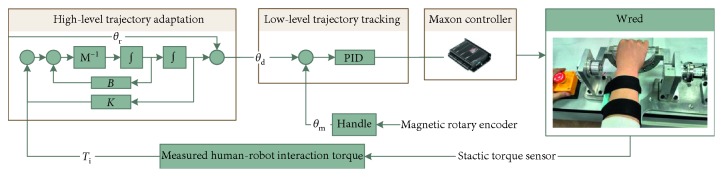
The control diagram of the WReD.